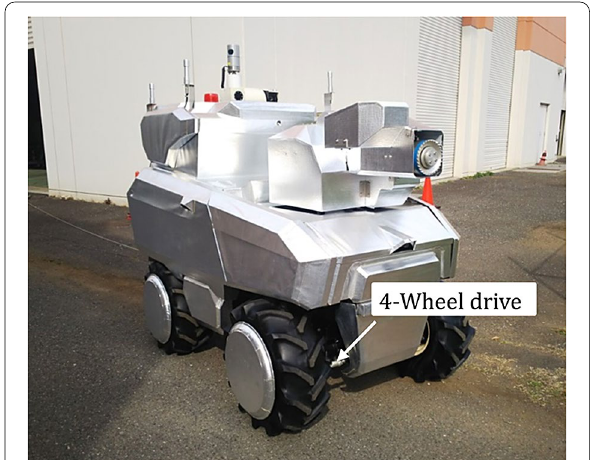
Fig. 1 Water cannon robot